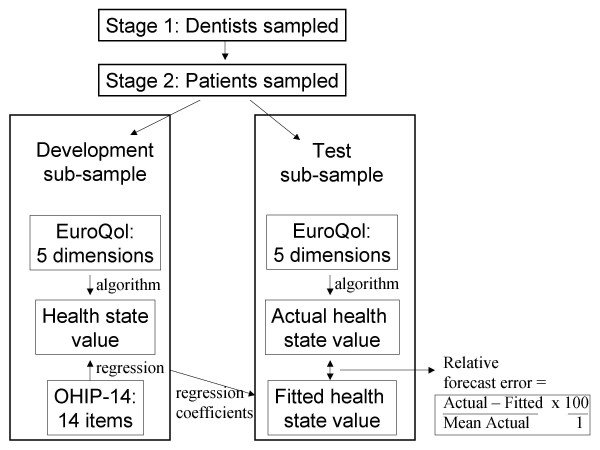
Outline of sampling and analysis.